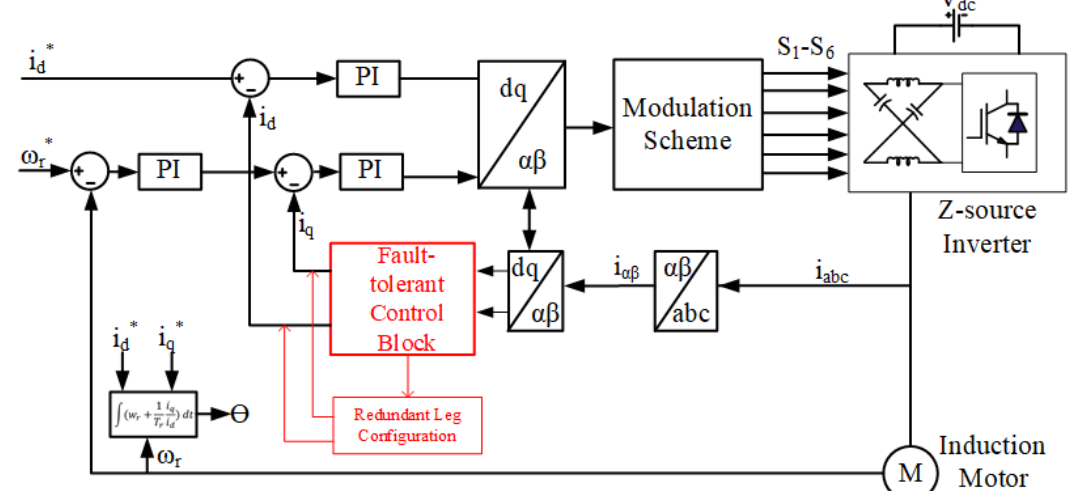
Figure 5. Control scheme of the proposed fault-tolerant